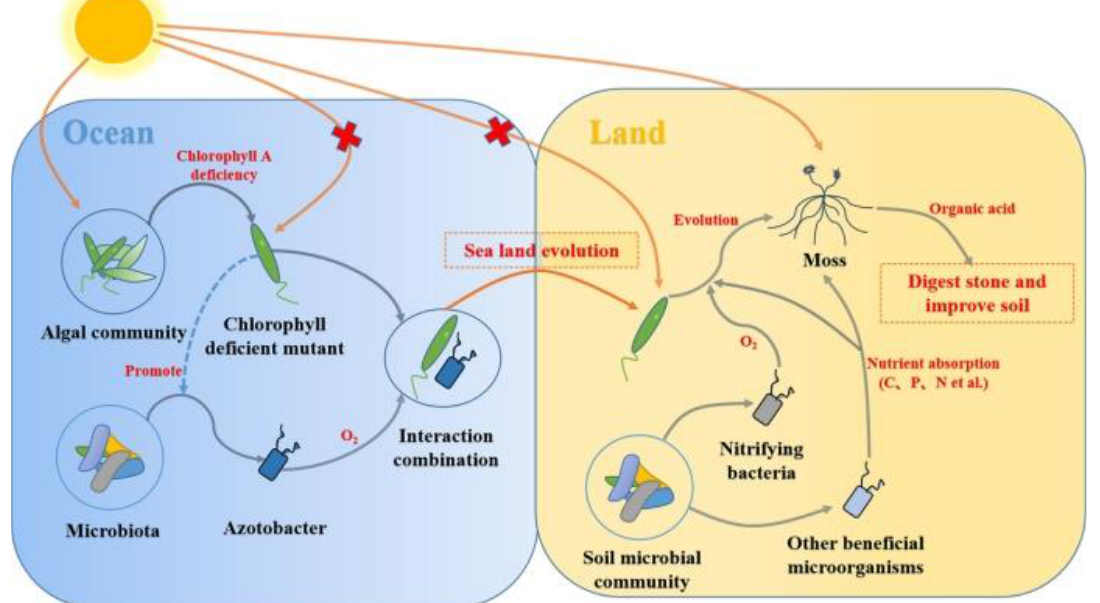
Figure 1. Model diagram of endophytes promoting the evolution of lower plants from aquatic to terrestrial conditions. In the ocean, the evolution of chlorophyll-a made it possible for lower algae to obtain O 2 by forming interactions with nitrogen-fixing bacteria and then migrate onto land. On land, nitrifying bacteria and other beneficial microorganisms can obtain O 2 and nutrients needed to